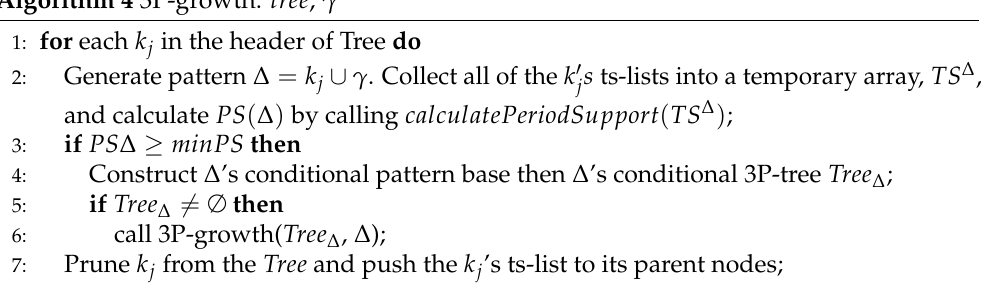
Algorithm 4 3P-growth: tree , γ